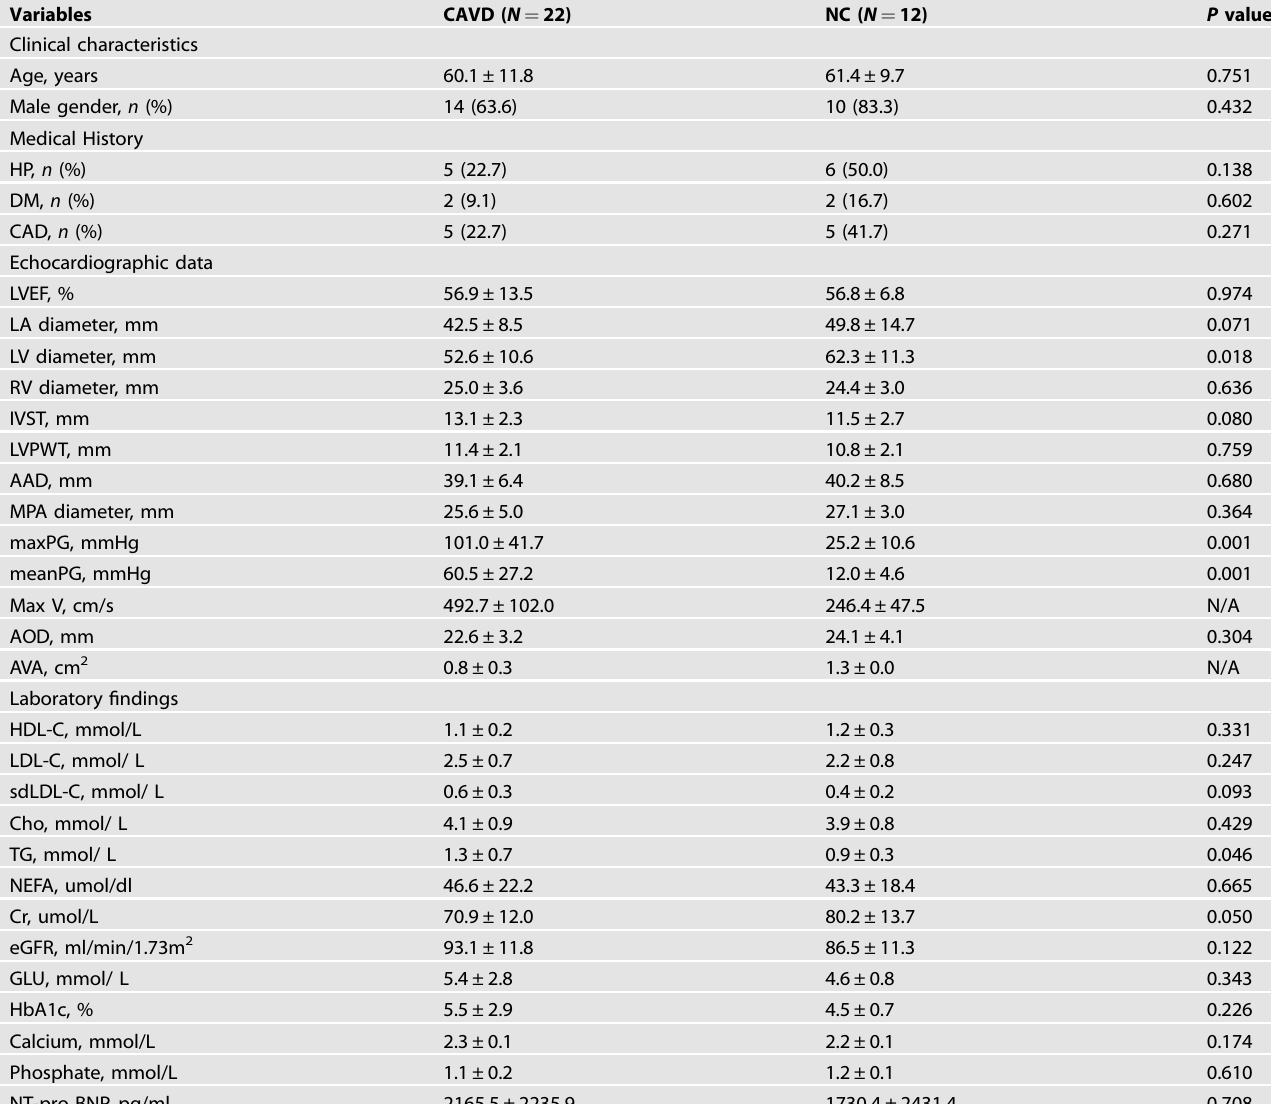
Table 1. Baseline